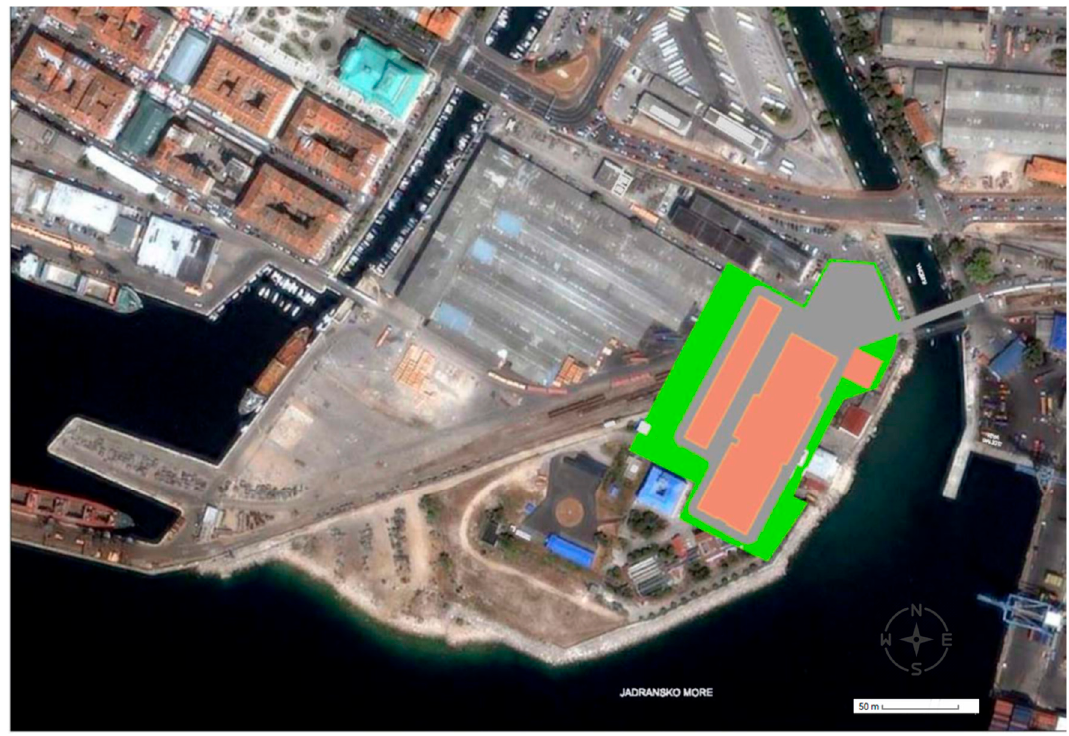
Figure 2. Location of the future WWTP Rijeka.